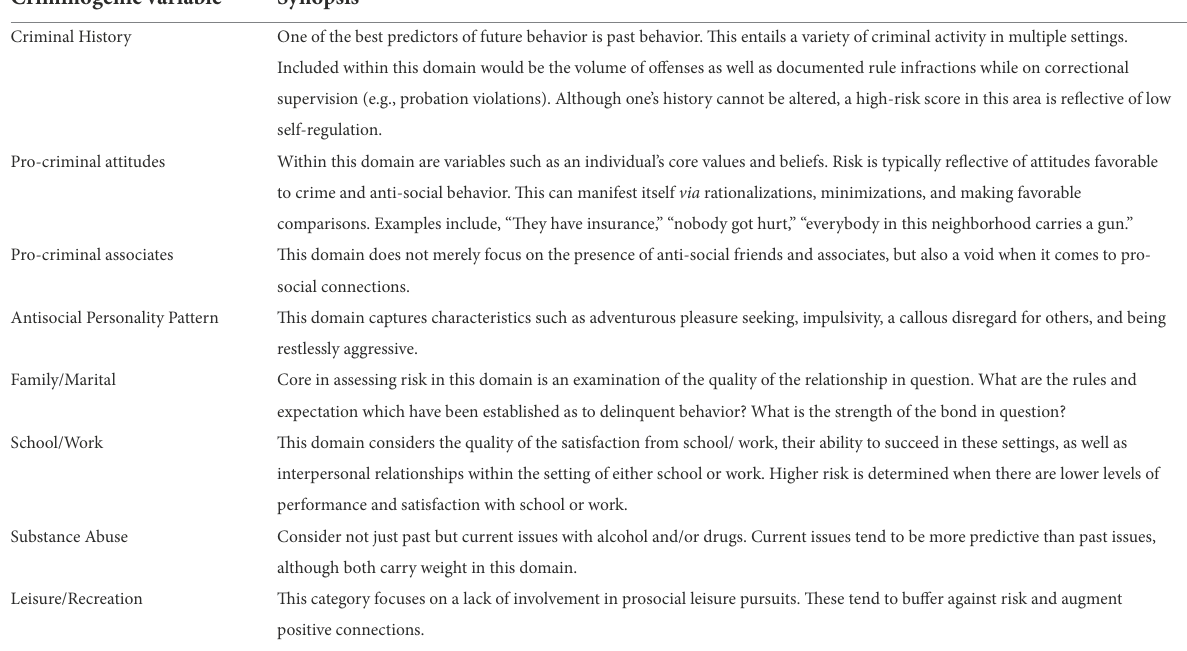
TABLE 1 The Central Eight Risk/Need